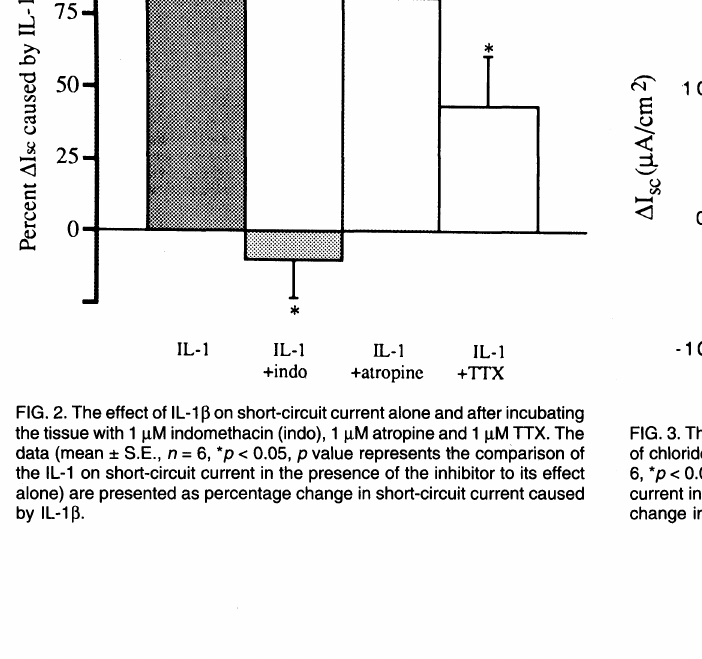
FIG. 3. The effect of IL-113 on short-circuit current alone and in the presence of chloride-free buffer or bumetanide (10 lLtM)..The data (mean +/- S.E., n 6, *p < 0.05. p value represents the comparison of the IL-1 on short-circuit current in the presence of the inhibitor to its effect alone) are presented as change in short-circuit current caused by